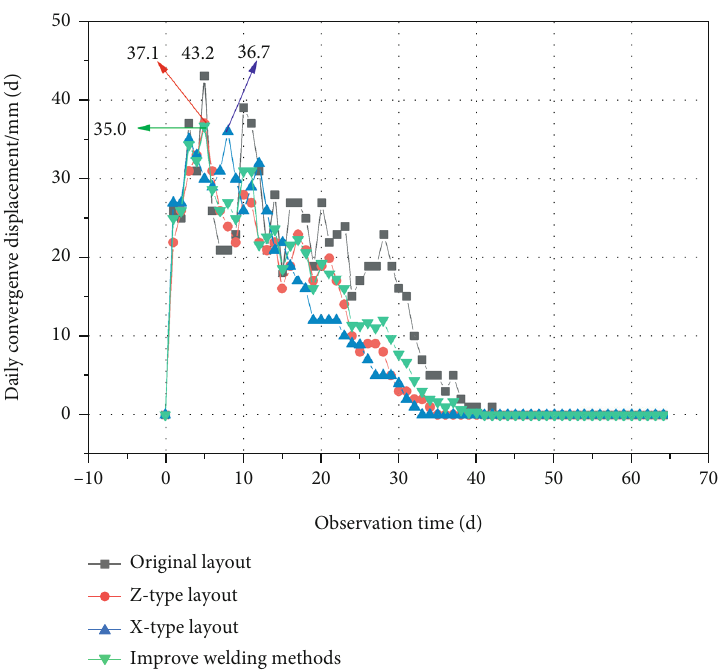
Figure 15: Comparison of convergence values around the tunnel under di ff erent arch optimization